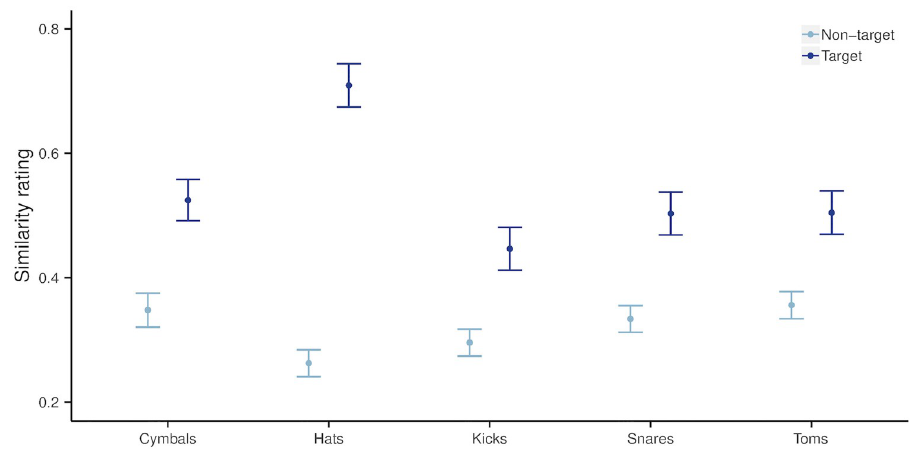
Fig 3. Comparison of similarity ratings between imitations and target vs. non–target sounds, by drum category. Values are mean rating parameter estimates with 95% Wald confidence intervals.